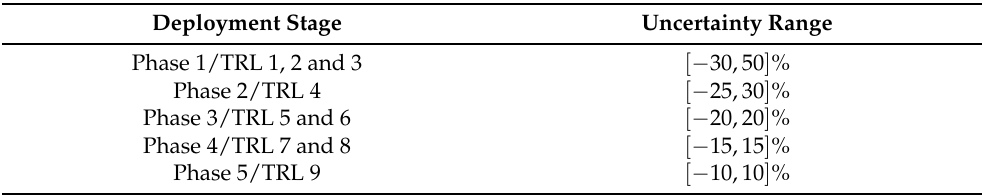
Table 8. The uncertainty of the LCoE estimates as a function of the development stage [55]. Data adapted from